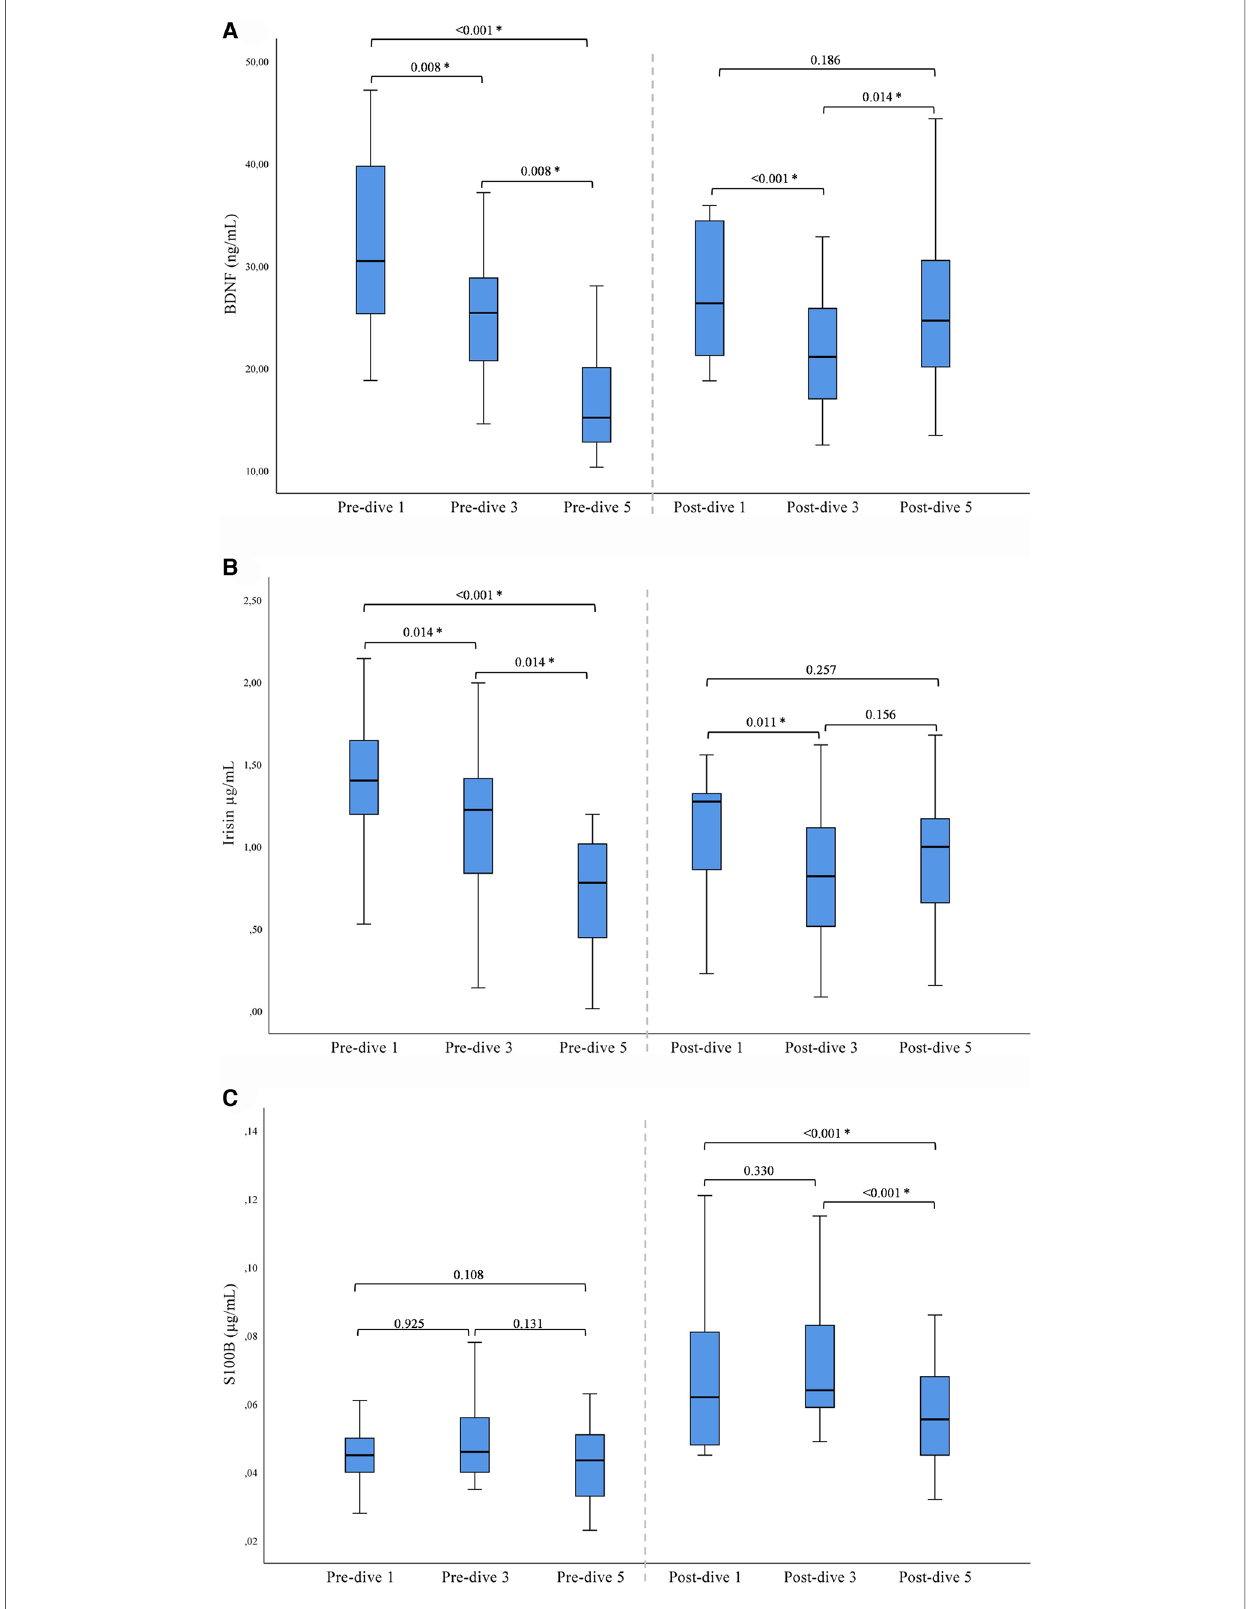
FIGURE 1 Results of post-hoc analysis for BDNF ( A ), irisin ( B ), and S100B ( C ) presented with box plots (median±IQR). *Statistically signi fi cant change ( P <0.017) (Wilcoxon tests with a Bonferroni